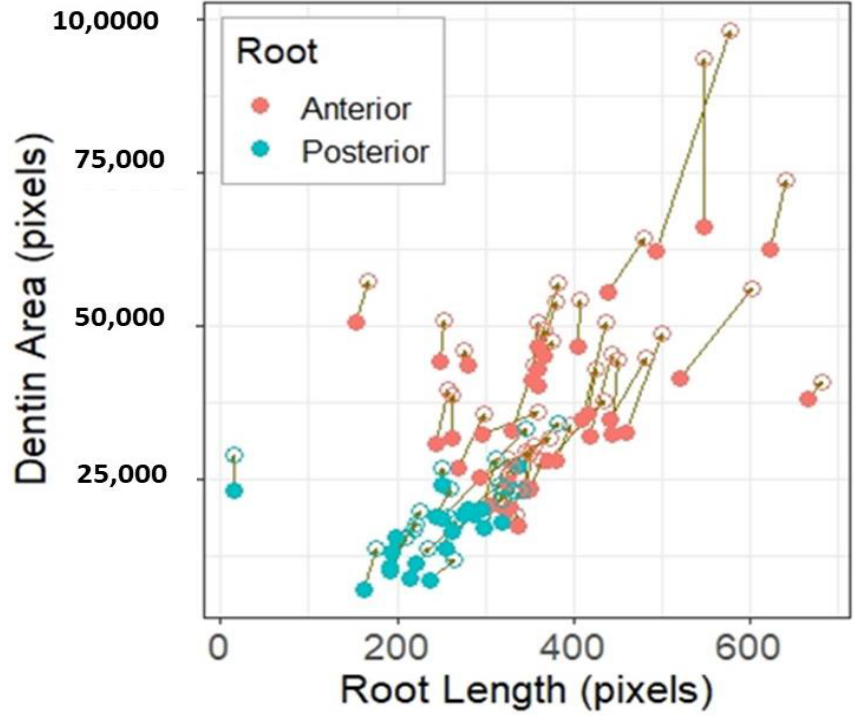
Figure 5. Summary of RRA (radiographic root area) and root length measurements. Solid and open circles represent the root dimensions before the procedure and at the follow-up visit, respectively. Each pair of before/after measurements for the same root is connected by an arrow. Orange and coral colours represent anterior and posterior roots, respectively.